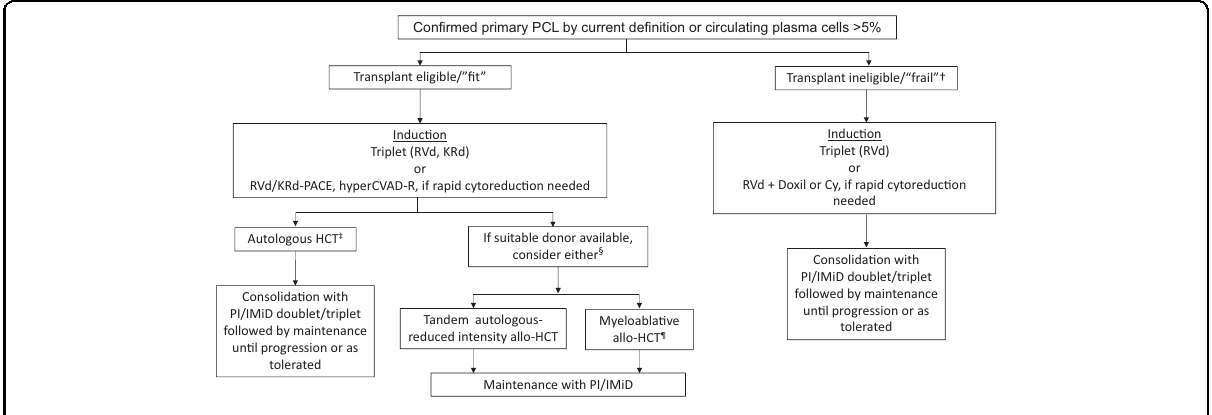
Fig. 1 Proposed treatment algorithim for plasma cell